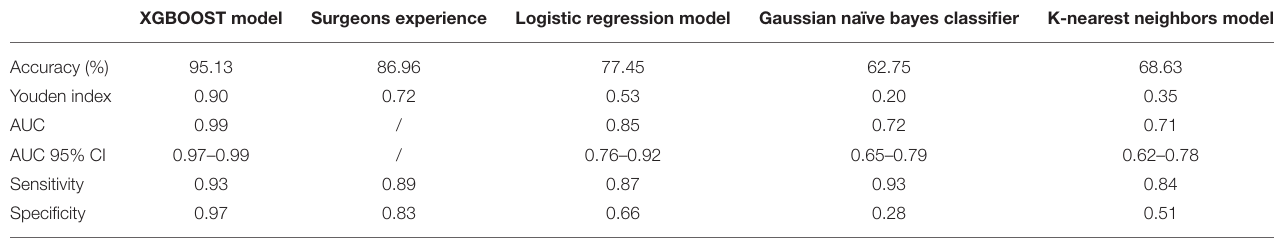
TABLE 3 | The ability of different model and surgeons experience to predict the need for perioperative red blood cells transfusion in test subset (binary classifications).